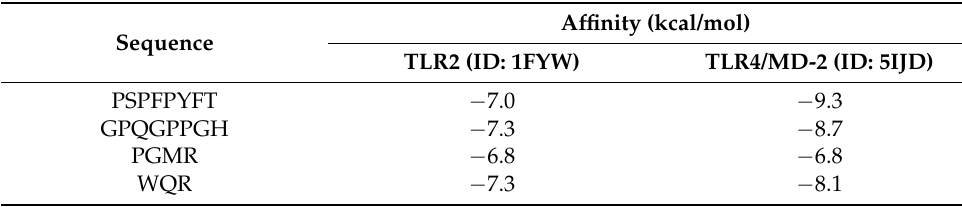
Table 3. Molecular docking analysis of the peptides by AutoDock